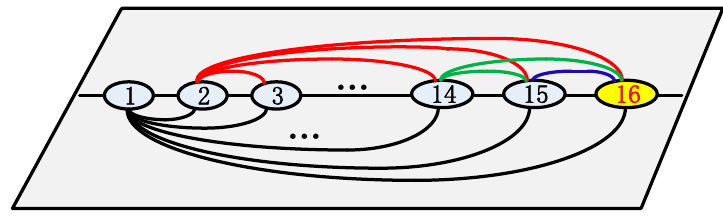
Figure 4. Mode of cycle measurement.